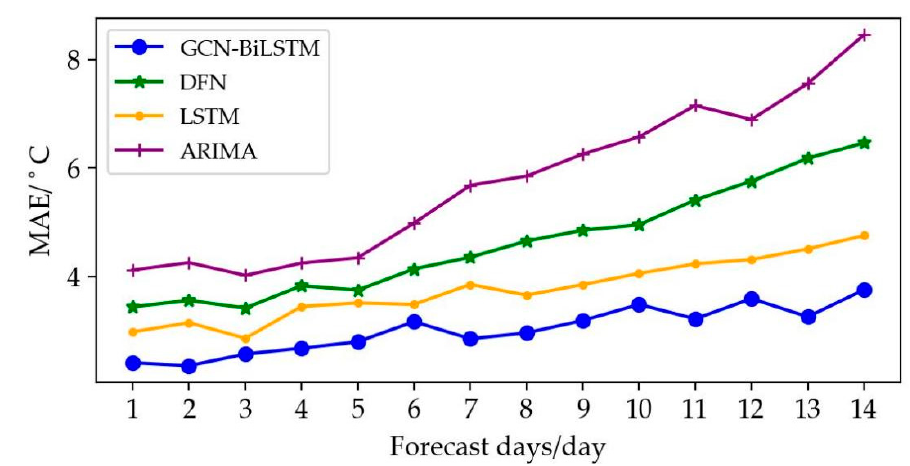
Figure 8. Comparison of MAE of temperature prediction for the next 14 days.